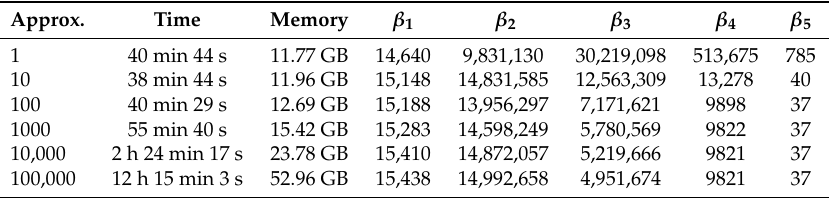
Table 3. Performance of F LAGSER on the Blue Brain Project graph with respect to different values of the Approximate parameter. The Betti numbers computed are an approximation to the true Betti numbers. See Table 4 for accuracy. Approx.